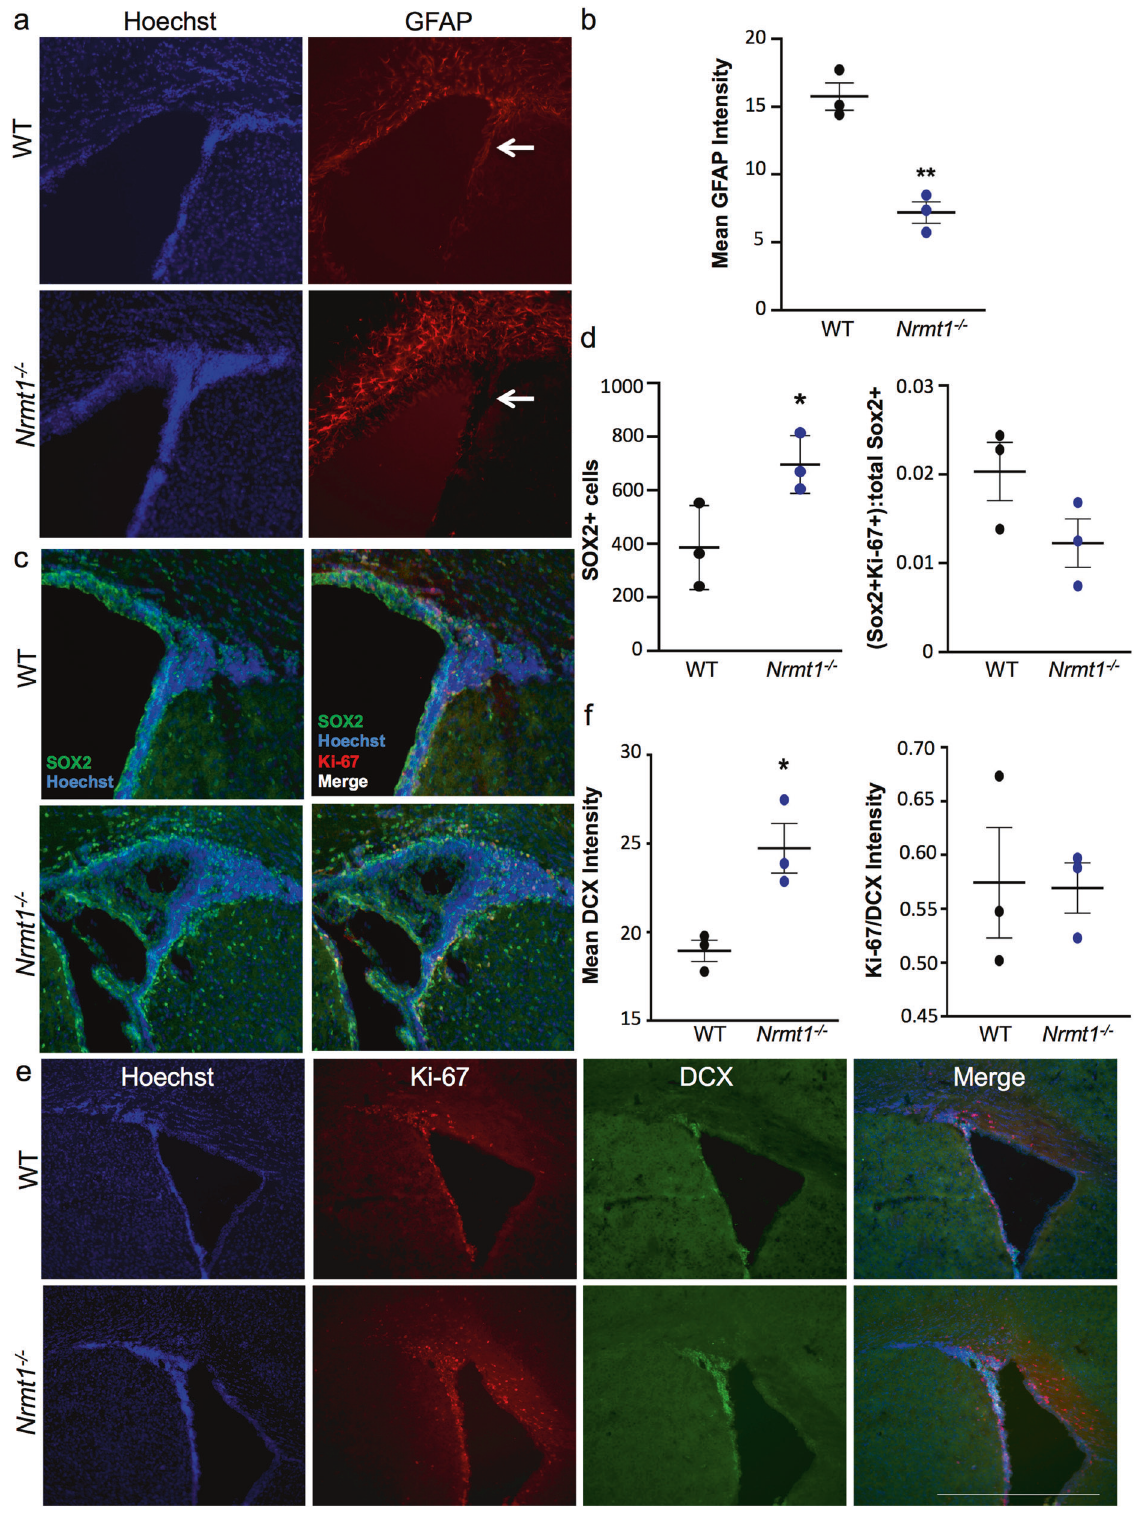
Fig. 4 At P14, Nrmt1 − / − mice exhibit an expansion of the IPC and neuroblasts pools in the SVZ. a , b GFAP staining is signi fi cantly decreased in the SVZ (arrows) of Nrmt1 − / − mice. However, there is a signi fi cant increase in c , d SOX2-positive IPCs and e , f Doublecortin (DCX)-positive neuroblasts in Nrmt1 − / − mice. Neither the d percentage of SOX2, Ki-67 double-positive cells, or the f ratio of Ki-67/DCX intensity in Nrmt1 − / − mice is signi fi cantly different from WT, indicating proliferation is not occurring at these stages. * p < 0.05 and ** p < 0.005 as determined by unpaired t -test, n = 3. Error bars represent mean ± SEM. Scale bar = 1000 μ